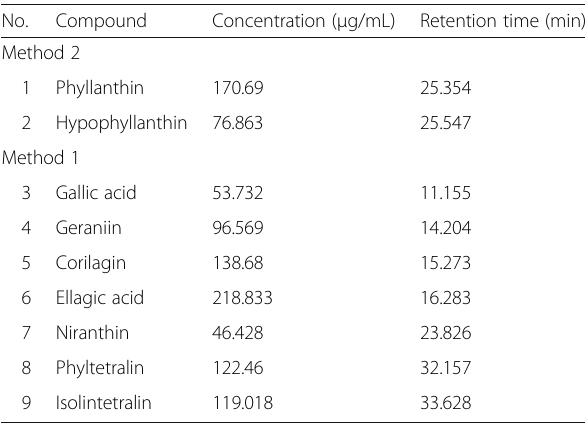
Table 1 Quantification of the major compounds found in Phyllanthus amarus ( μ g/mL) by using HPLC quantification assay No.